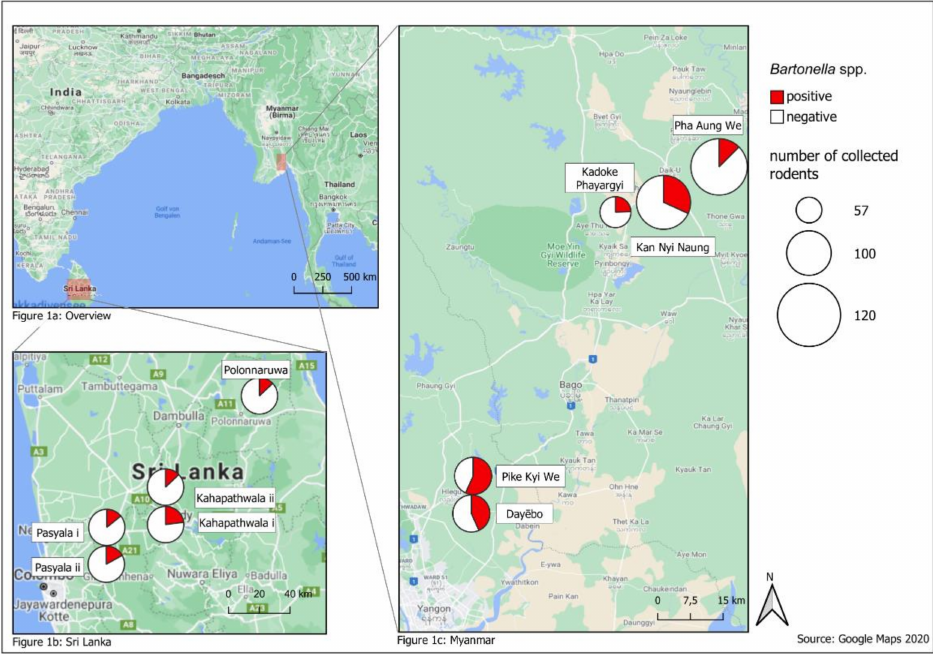
Figure 1. Study sites shown in overview (Figure 1a) and in detail in Sri Lanka (Figure 1b) and Myanmar (Figure 1c): Distribution of Bartonella spp. DNA positive small mammals. (Maps: QGIS 3.2.1 “Bonn”, Open Source Geospatial Foundation